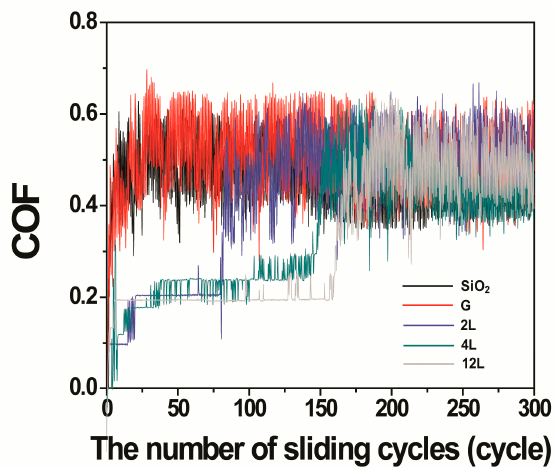
Figure 6. Coefficients of friction (COF) obtained under high pressure from 2L MoS 2 , 4L MoS 2 , 12L MoS 2 , 1L graphene and bare SiO 2 /Si for up to 300 cycles of sliding.